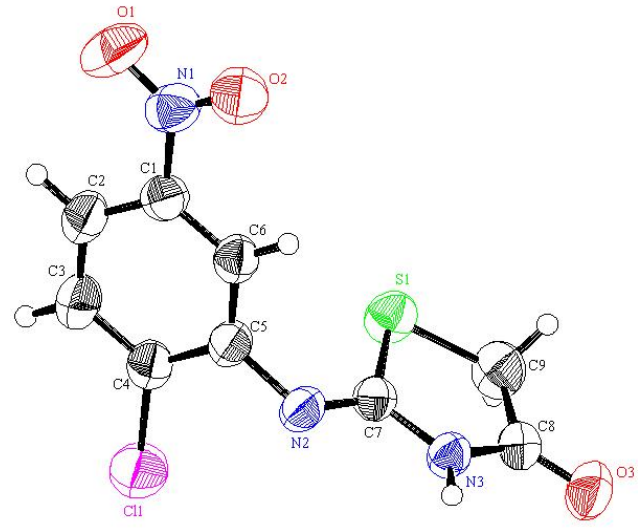
Figure 2. ORTEP plot of the X-ray crystallographic data determined for 3a . Crystallo- graphic data have been deposited with the Cambridge Crystallographic Data Centre as supplementary publication number CCDC 874280